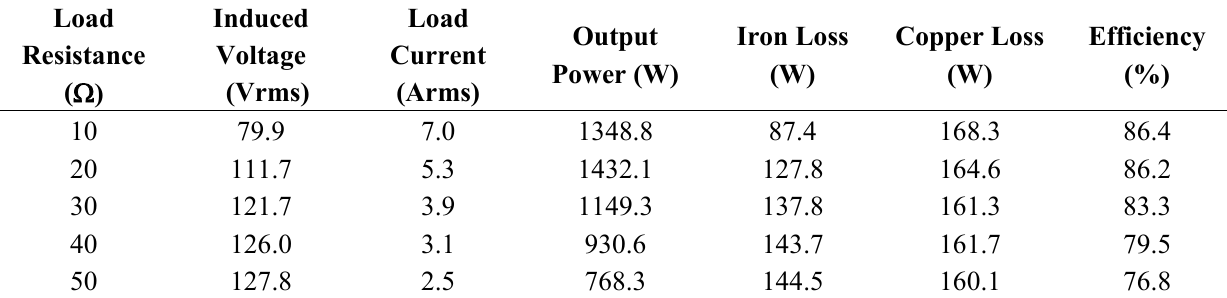
Table 2. Output power and efficiency (sinusoidal wave).